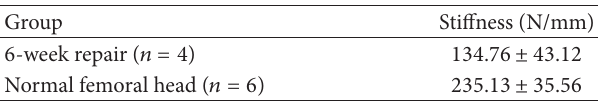
Table 1: Stiffness of bony part in the osteochondral restoration area. Group Stiffness (N/mm) 6-week repair ( 𝑛 = 4 ) 134.76 ± 43.12 Normal femoral head ( 𝑛 = 6 ) 235.13 ± 35.56 ∗ 𝑃 < 0.05 versus control compared to normal femoral